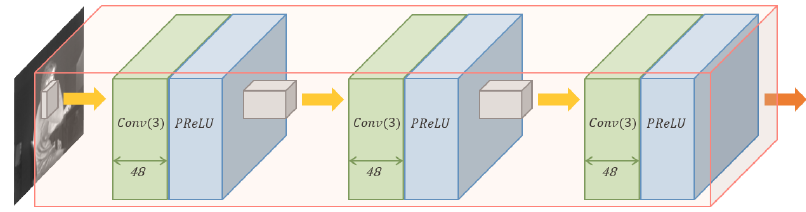
Figure 2. Visualization of the feature extraction module.